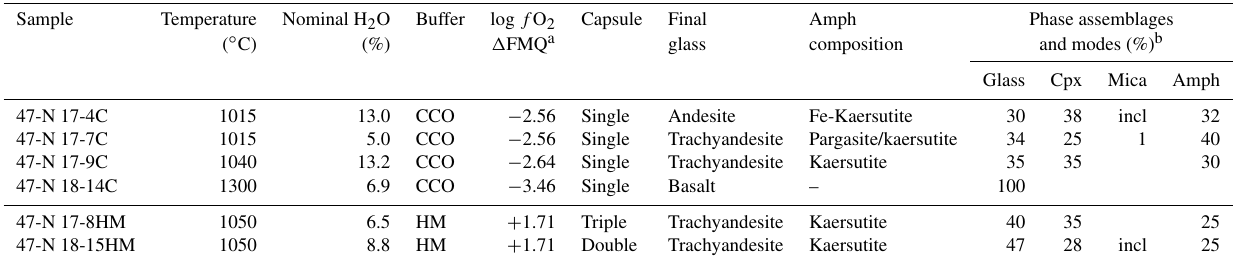
Table 2. Summary of experimental conditions and run products. Sample